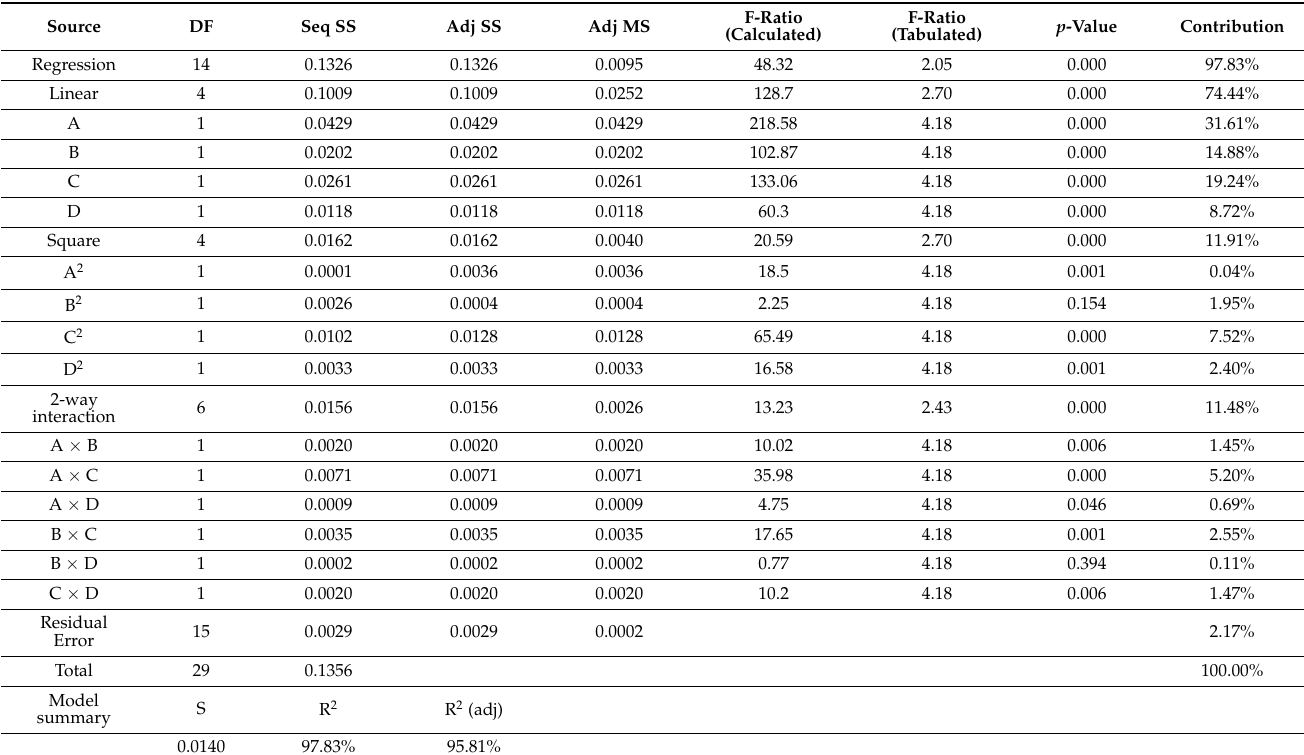
Table 13. ANOVA for delamination factor of MoS 2 -loaded CEC.